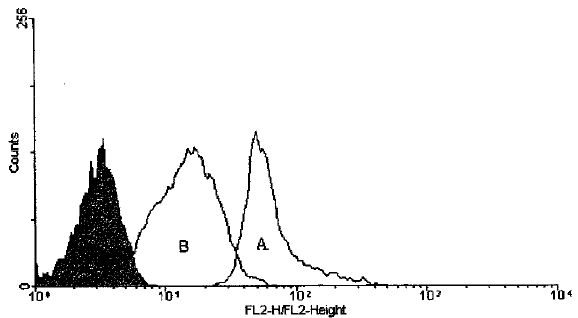
FIG. 1. An example of CD13 Ag expression on peripheral blood lymphocytes during the course of acute exacerbation of MS (A) in MS remission (B) and other neurological diseases